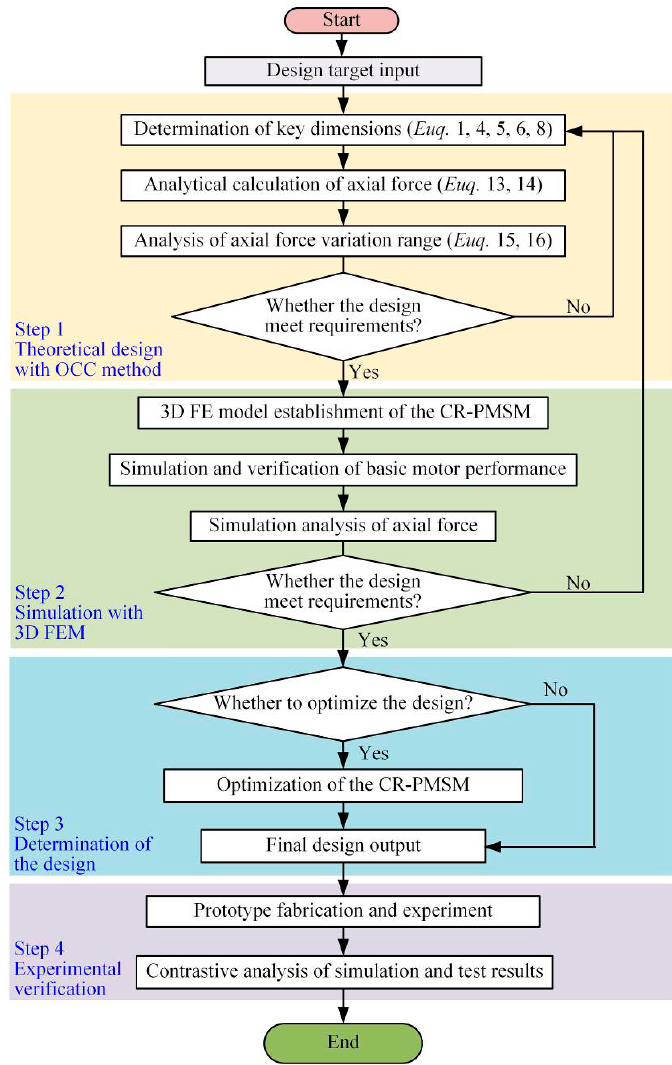
Figure 14. Technique flowchart of the proposed CR-PMSM.